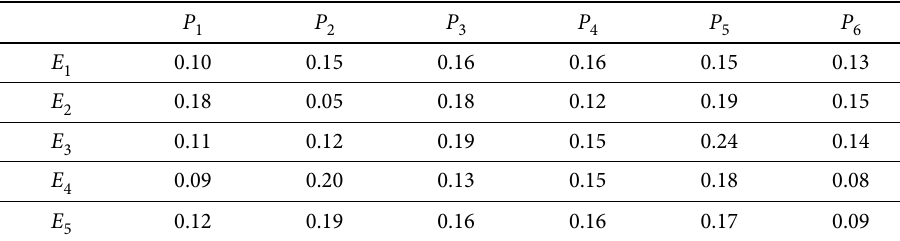
Table 6. Aggregated distances with IOWAD